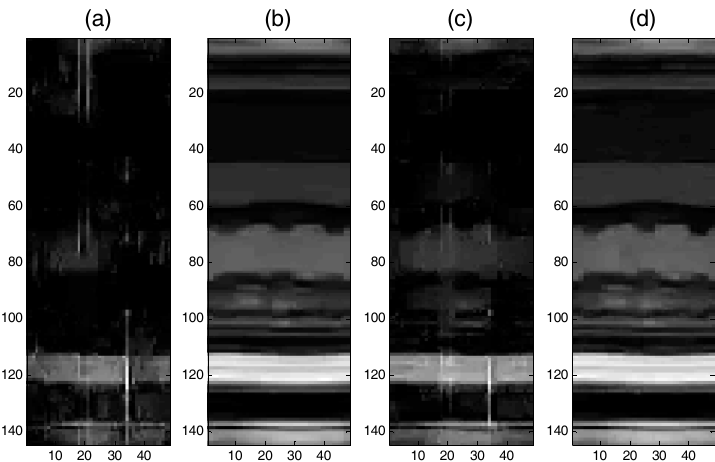
Figure 12. The recovery effects of the proposed SAITA- L p ( p ∈ { 1/2, 2/3 } ) and the corresponding L 1/2 and L 2/3 algorithm for the M / N = 0.2, mSNR = 40 dB 2D MRI image. ( a ) L 1/2 algorithm, RSNR = 3.6346 dB; ( b ) SAITA- L 1/2 algorithm, RSNR = 21.0189 dB; ( c ) L 2/3 algorithm, RSNR = 7.7718 dB; and ( d ) SAITA-L 2/3 algorithm, RSNR = 23.1872 dB .